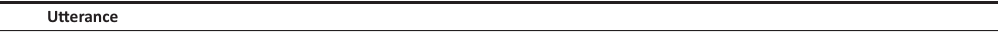
TABLE 1: Extract of a learner